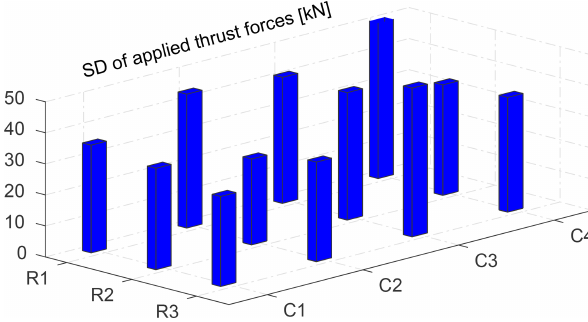
Figure 5. SD of the applied thrust forces on the individual wind turbines operating with the greedy induction factors a i = 1 /